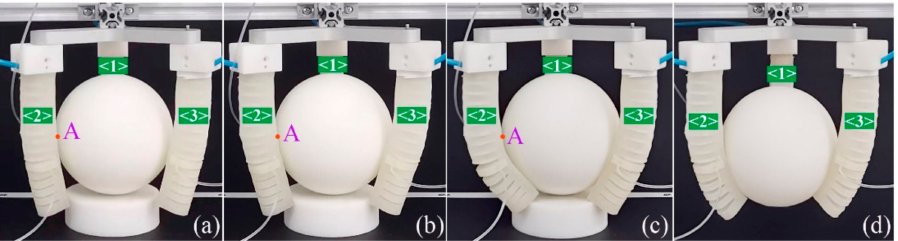
Figure 15. Grasping process of a sphere: ( a ) the soft actuator approaches the sphere when the pressure of module one is 25 kPa and that of module two is zero; ( b ) the soft actuator’s tip can contact the sphere when the pressure of module one is 29 kPa and that of module two is zero; ( c ) the gripper envelops the sphere tightly when the pressure of module one is 40 kPa and that of module two is zero; ( d ) the sphere is grasped stably when the heel block is